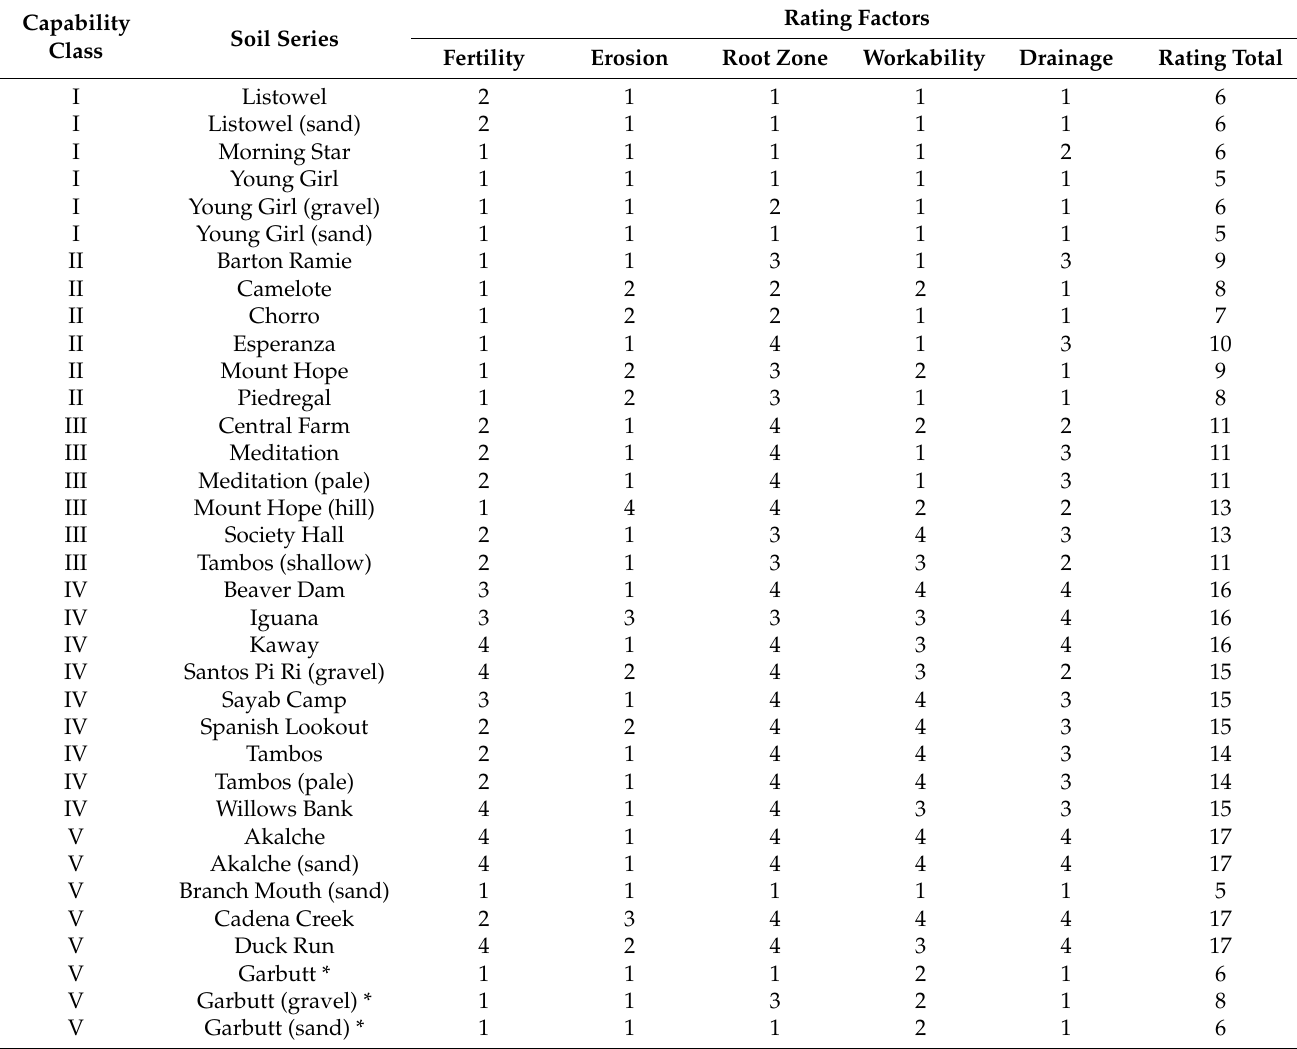
Table 2. Agricultural capability assessment for all soil series in the study area. Adapted from Fedick [23] (Table 1) with the addition of previously unpublished assessments by Fedick for soils on the south side of the